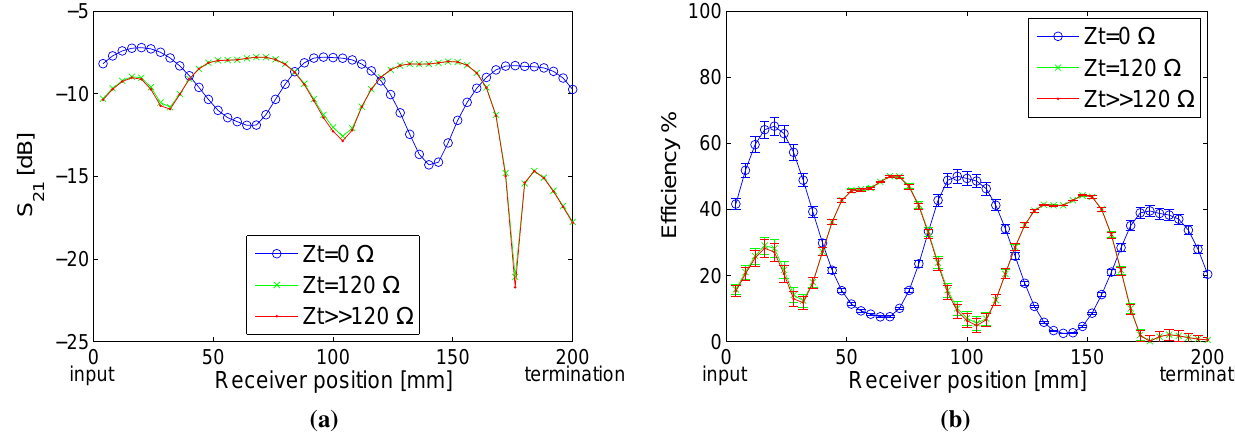
Figure 8. Measurements of S ( a ) and adjusted efficiency ( b ) as a function of the receiver 21 position for the termination impedances used and at f = f 0